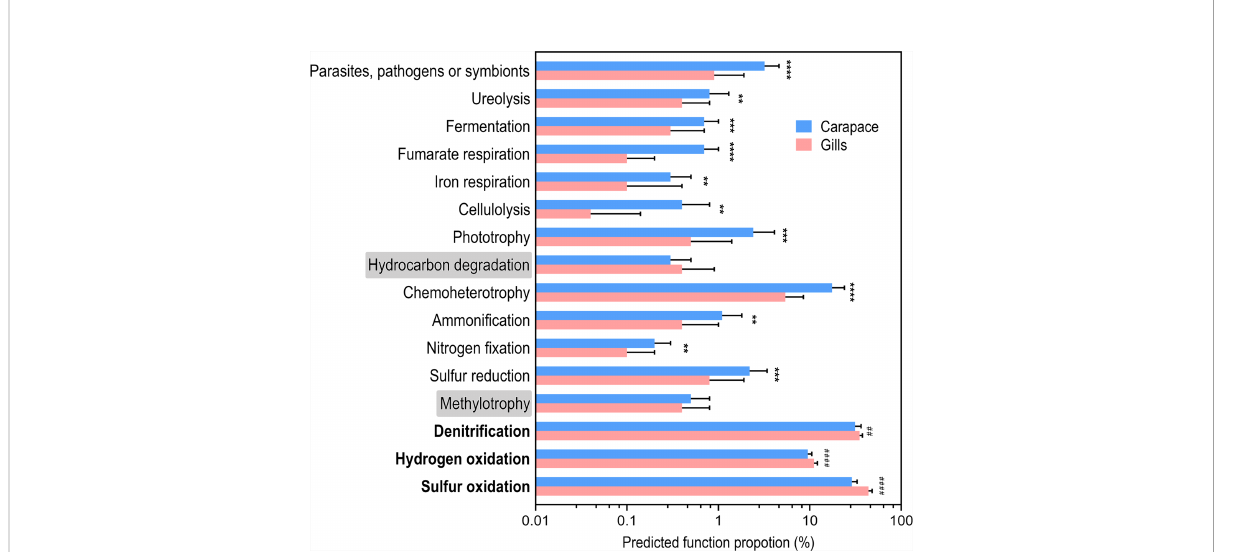
FIGURE 5 Predicted function proportions based on the functional annotation of prokaryotic taxa (FAPROTAX). The proportions of predicted bacterial functions are shown in the barplot. Values are mean + SD. Asterisks indicate groups that are signi fi cantly higher in the carapace than the gill. The hash signs indicate groups that are signi fi cantly higher in the gill than in the carapace. (Welch ’ s t -test; ** p < 0.01, *** p < 0.001, **** p < 0.0001, ## p < 0.01, #### p < 0.0001; gill, N = 29; carapace, N =